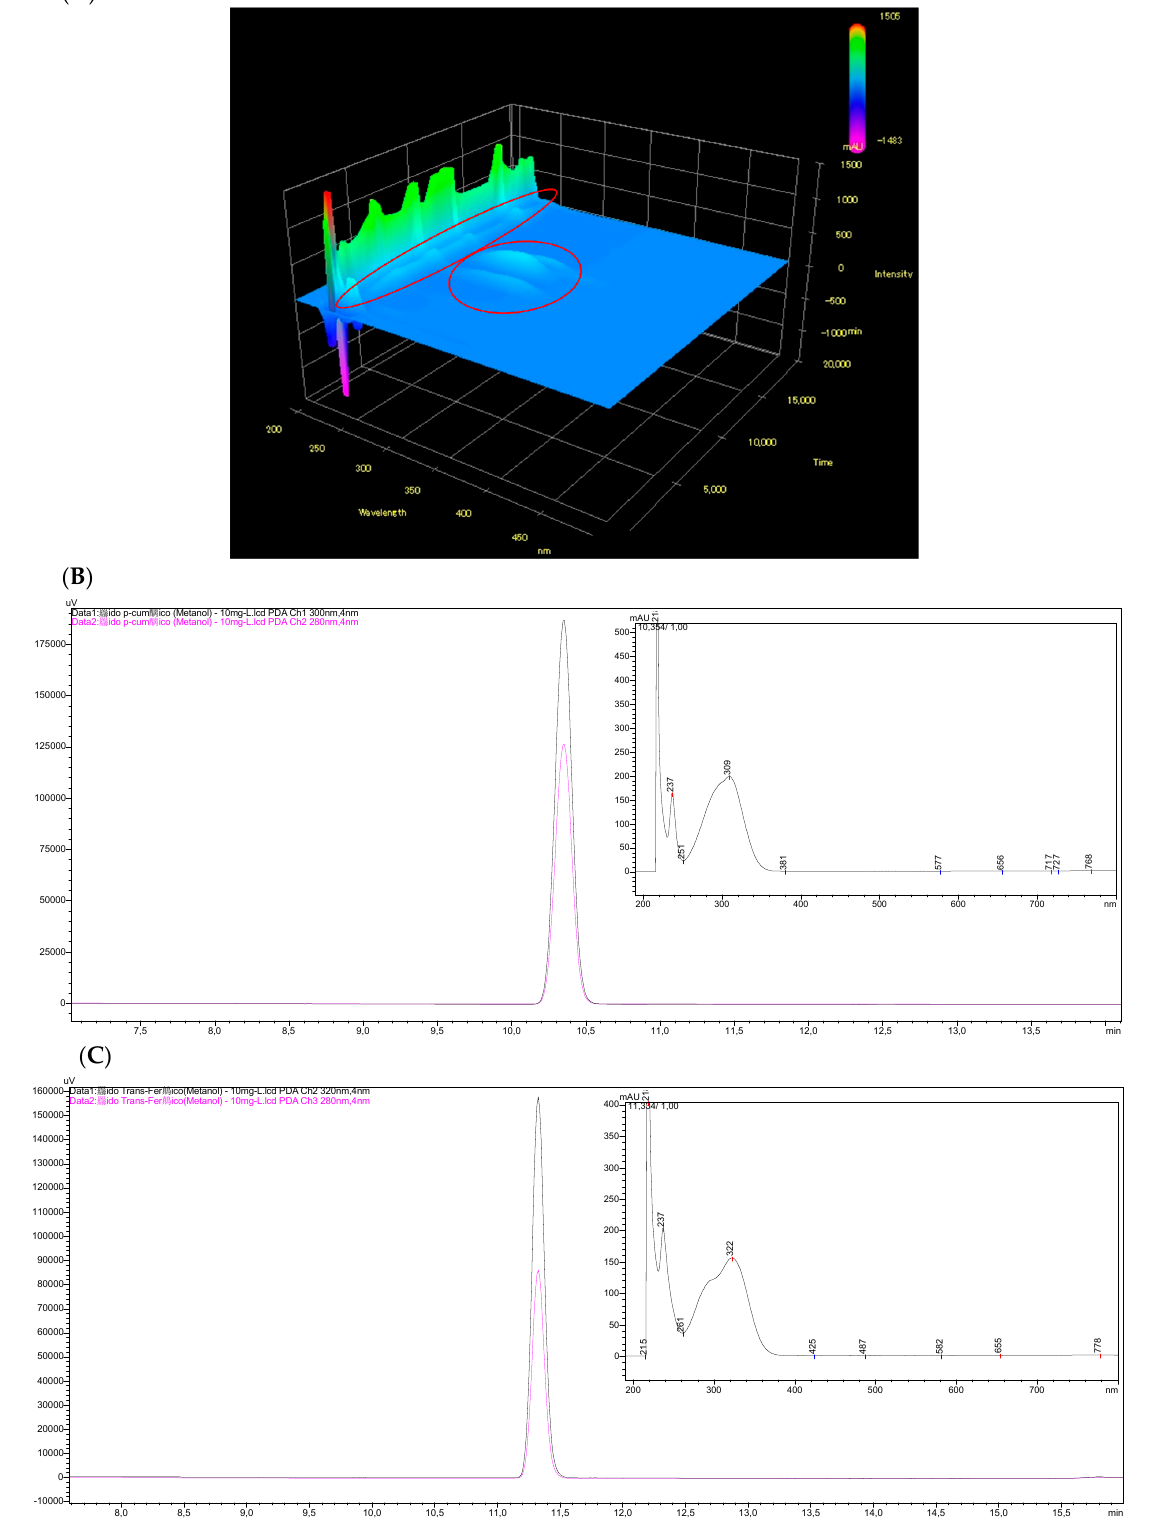
Figure 4. ( A ) 3D spectrum for a standard solution of phenolic compounds (12.5 mg L − 1 ); chromatograms and UV-vis spectra obtained for ( B ) p -coumaric acid (10 mg L − 1 ) and ( C ) trans -ferulic acid (10 mg L − 1 ), individually injected, for the choice of the wavelength of higher absorption of the electromagnetic radiation in the diode array detector (in the chromatograms: pink = 280 nm; black = 320 nm for p -coumaric acid; and 300 nm for trans -ferulic